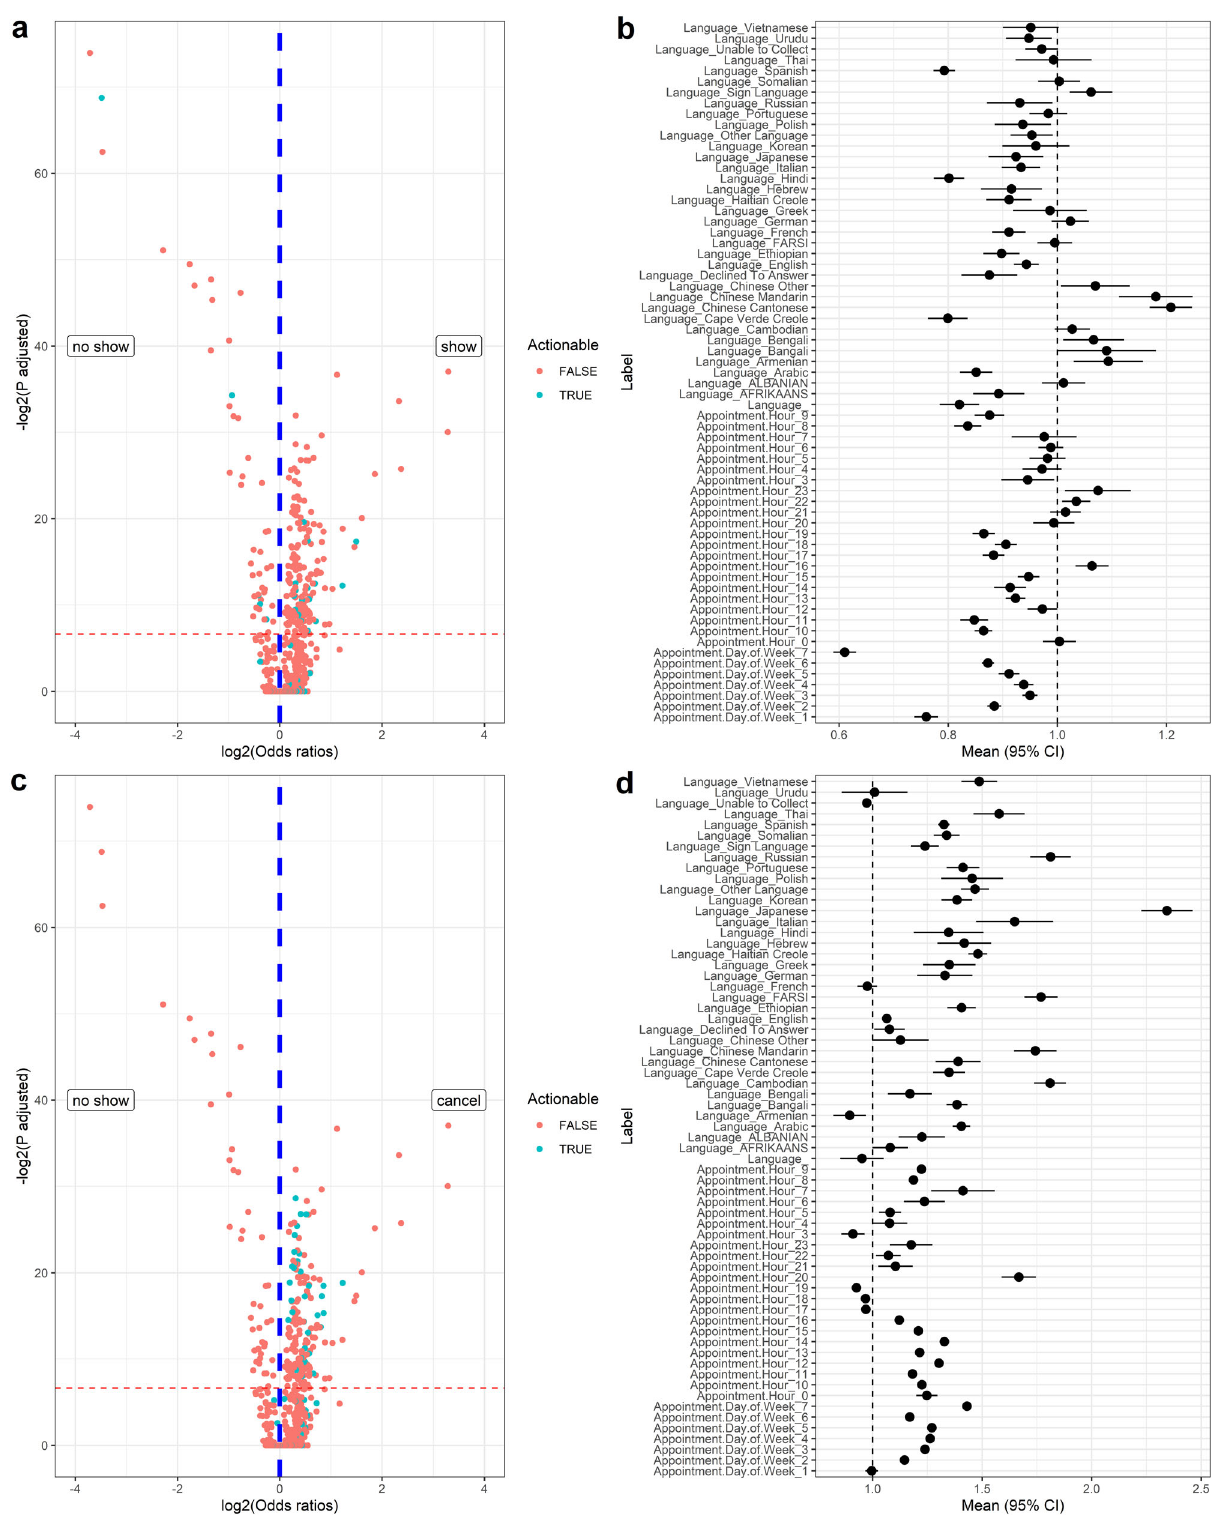
Fig. 6 Potential actionable factors associated with show and cancellation at appointments versus no-show. a Odds ratio (OR) and adjusted P values of association of different features with show (OR > 1, right) versus no-show (OR < 1, left) at appointments. The horizontal red dash line indicates adjusted P values = 0.01 and green dots are potentially actionable factors. b OR and their con fi dence intervals of potentially actionable items for show versus no-show. c OR and adjusted P values of association of different features with cancellation (OR > 1, right) versus no- show (OR < 1, left) at appointments. d OR and their con fi dence intervals of potentially actionable items for cancellation versus no-